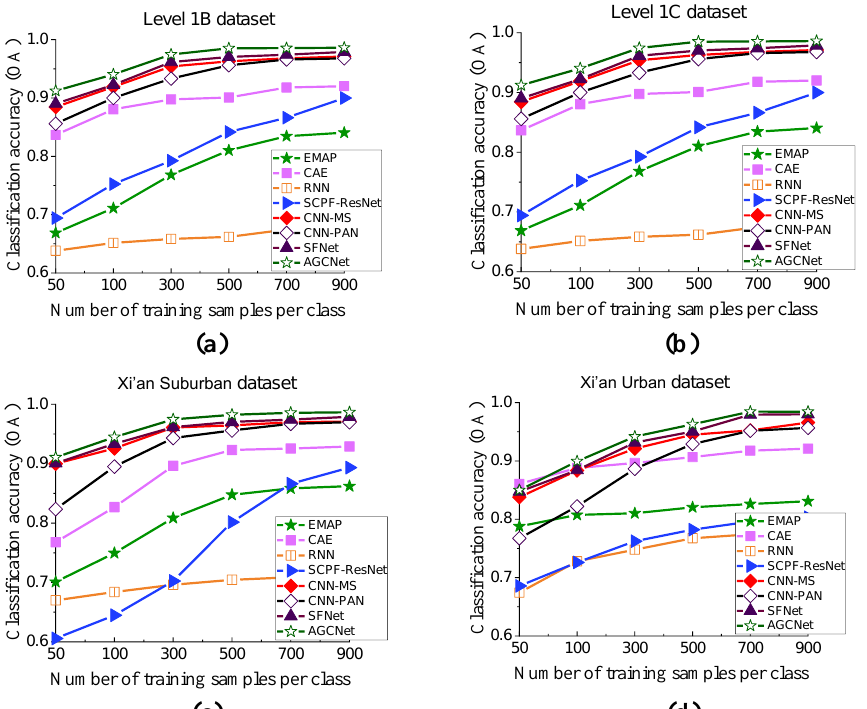
Figure 9. The classification accuracies with different number of training